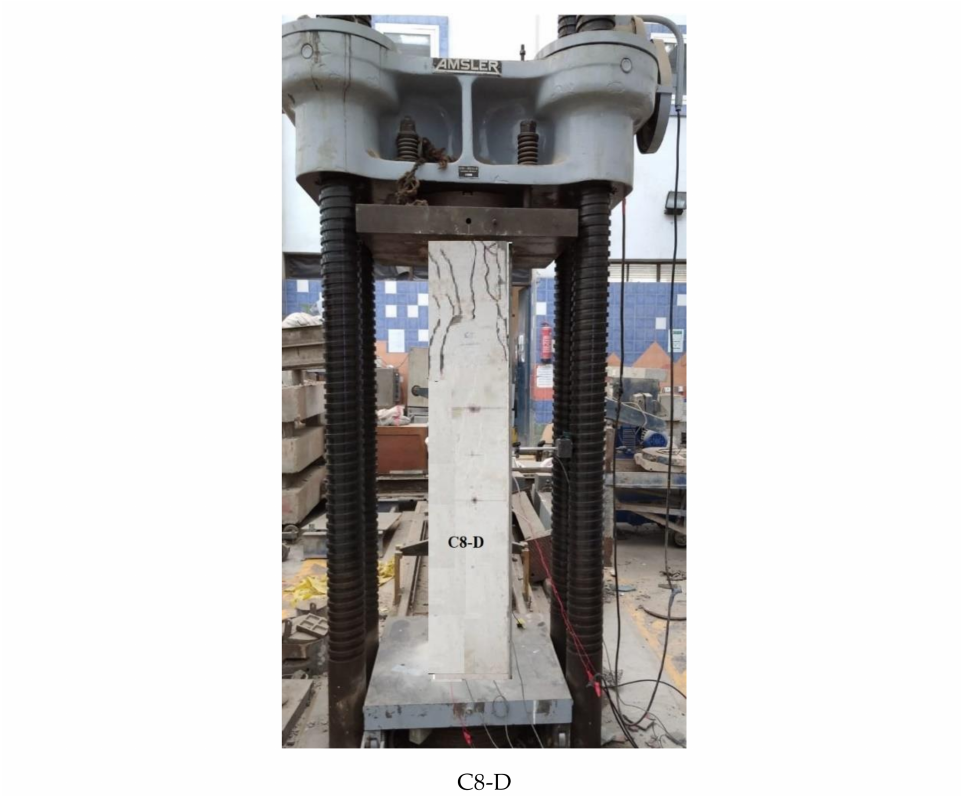
Figure 15. Crack